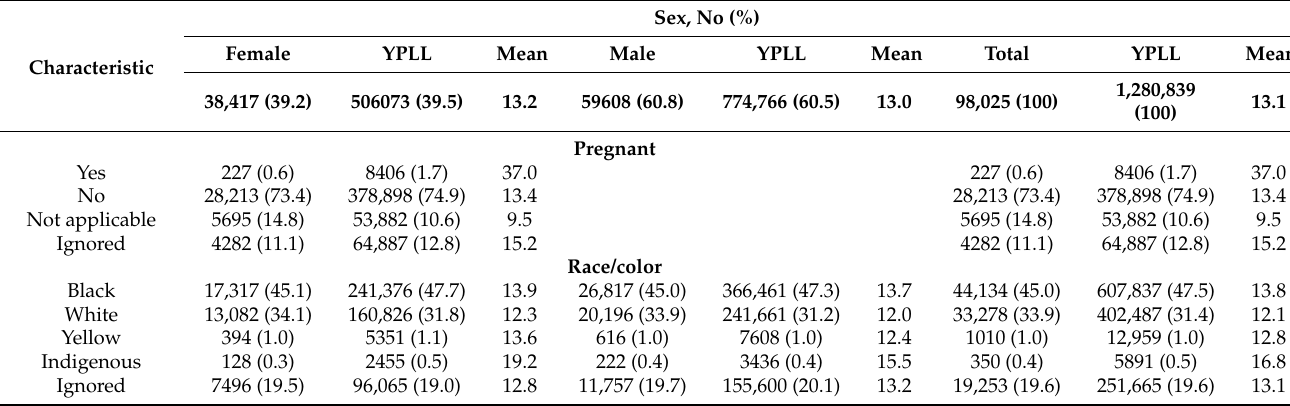
Table A2. Fatalities and years of potential life lost due to COVID-19 in Brazil (2020), by gender, race, zone of residence and risk